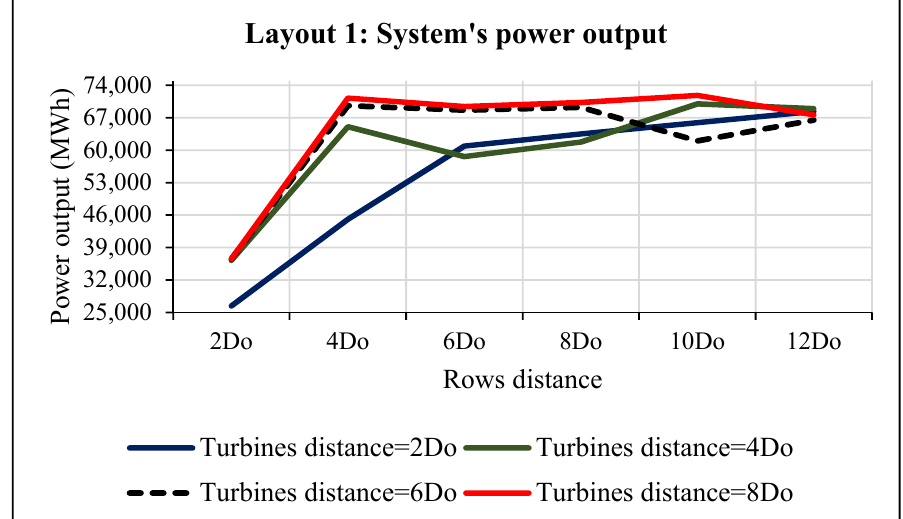
Figure 12. System’s power output for different distances between turbines and rows. For row spacing of 2D o and distance between turbines of 8D o , maximum wake loss is about 50%. A similar study [7] found a maximum wind deficit of approximately 45%, at a